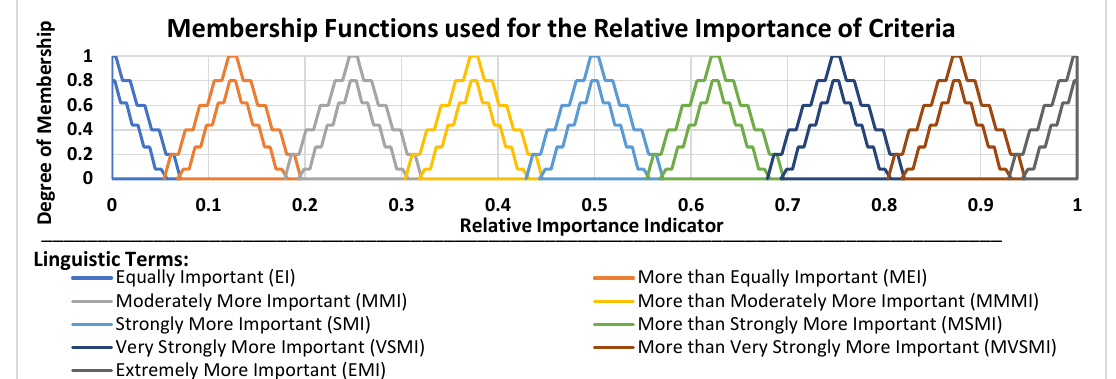
Figure 2. The membership functions used for the pairwise comparisons of